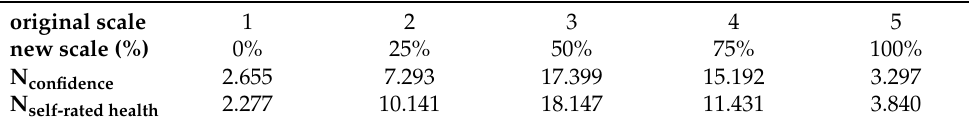
Table 2. Distribution of self-rated health and confidence in the health care system before and after